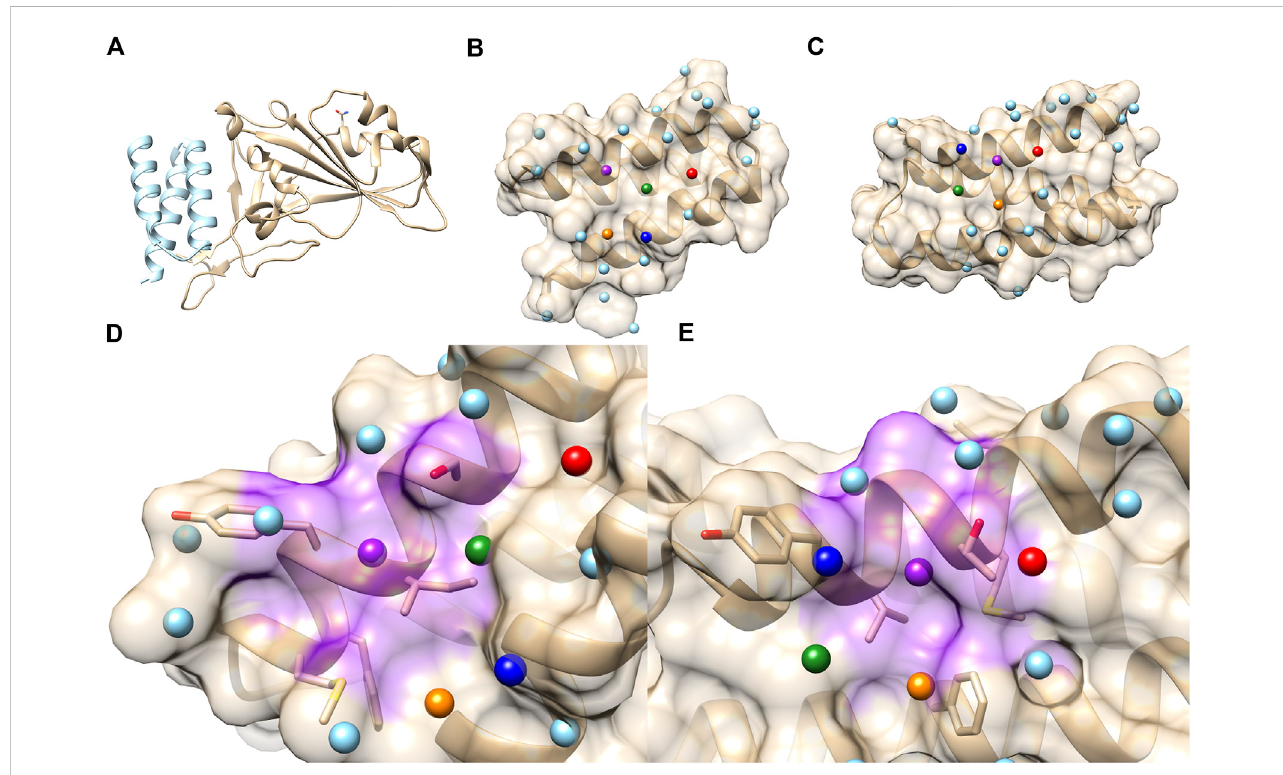
FIGURE 8 PPIsitesofLCB1andLCB3. (A) ThecrystalstructureoftheACE2RBDdomain(Gold)andLCB1(skyblue).PDBID:7JZU. (B) Thestructureandseedpoints (spheres) ofLCB1. (C) Thestructureandseedpoints(spheres)ofLCB3.Top5closestpatchpairsareindicatedbythesamecolor. (D,E) The closestpatchpairs (purple) from (D) (LCB1 #20) and (E) (LCB3 #12). The residues surrounding LCB1 #20 (ILE, SER, TYR, MET, and PHE) and LCB3 #12 (LEU, MET, THR, TYR, and PHE) are shown in a stick representation.